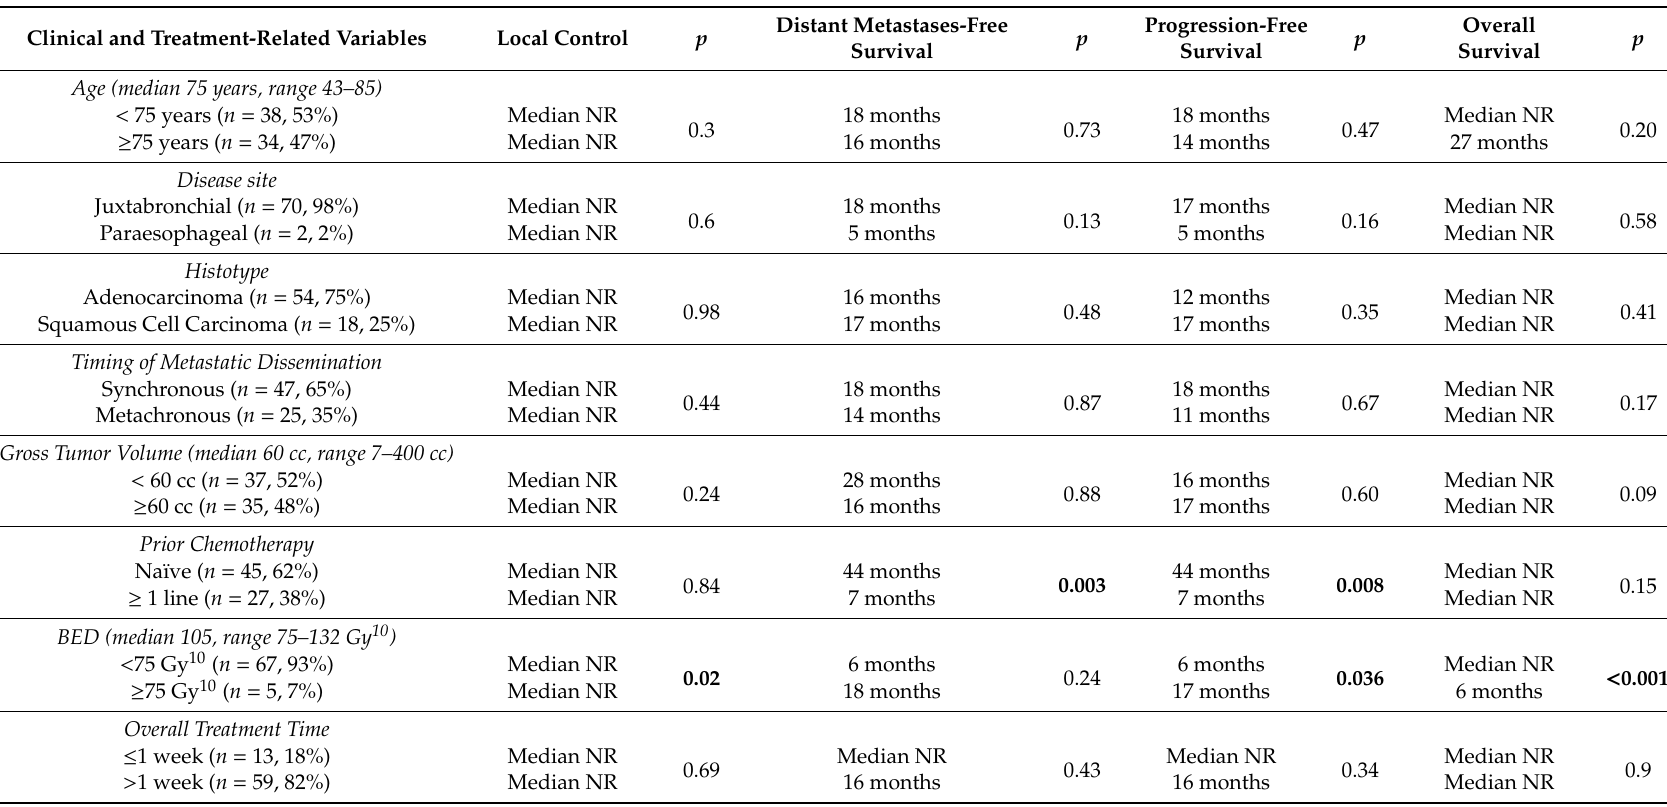
Table 1. Clinical and treatment-related variables and impact on local control, distant metastases-free survival, progression-free survival, and overall survival. NR: not reached; BED: biologically e ff ective dose. Italic: variable type. Bold: significant at statistical analysis ( p < 0.05). Clinical and Treatment-Related